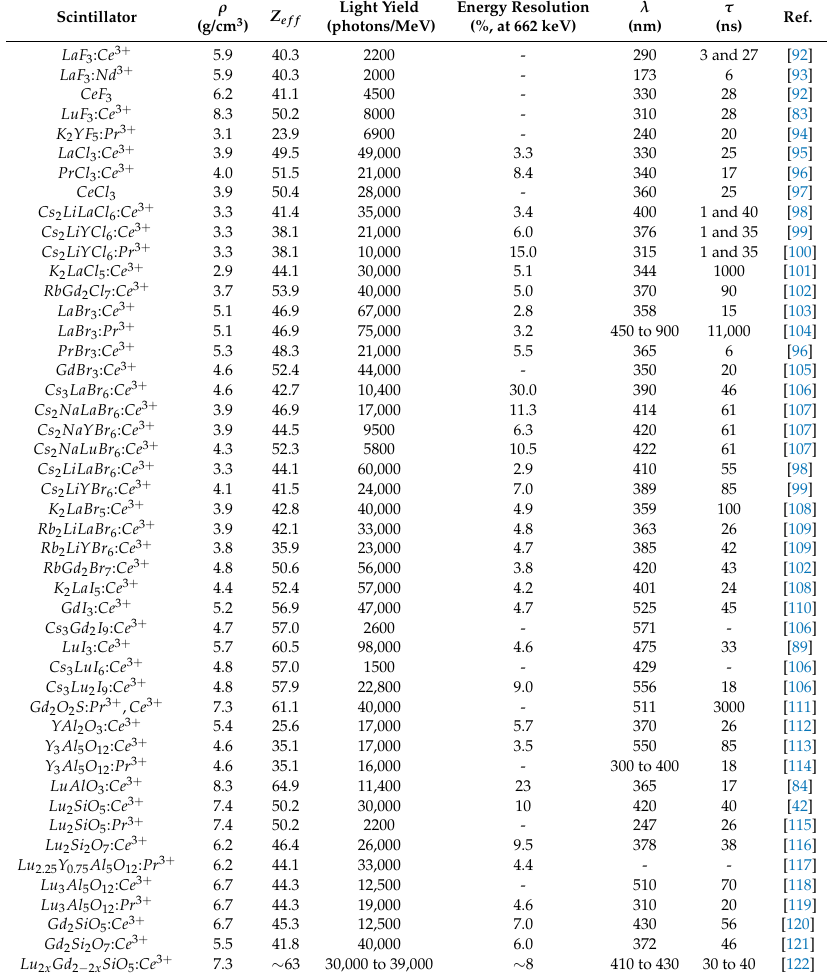
Table 3. Overview of some Ce 3 + , Pr 3 + , and Nd 3 + -doped inorganic scintillators. The same convention as in Table 1 is